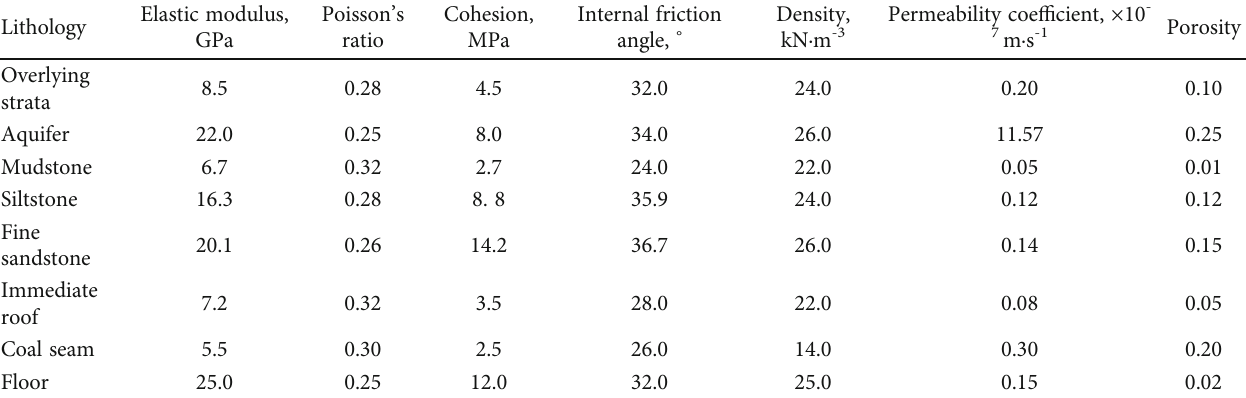
Table 1: The model geometry, physical, and mechanical parameters of overlying strata.